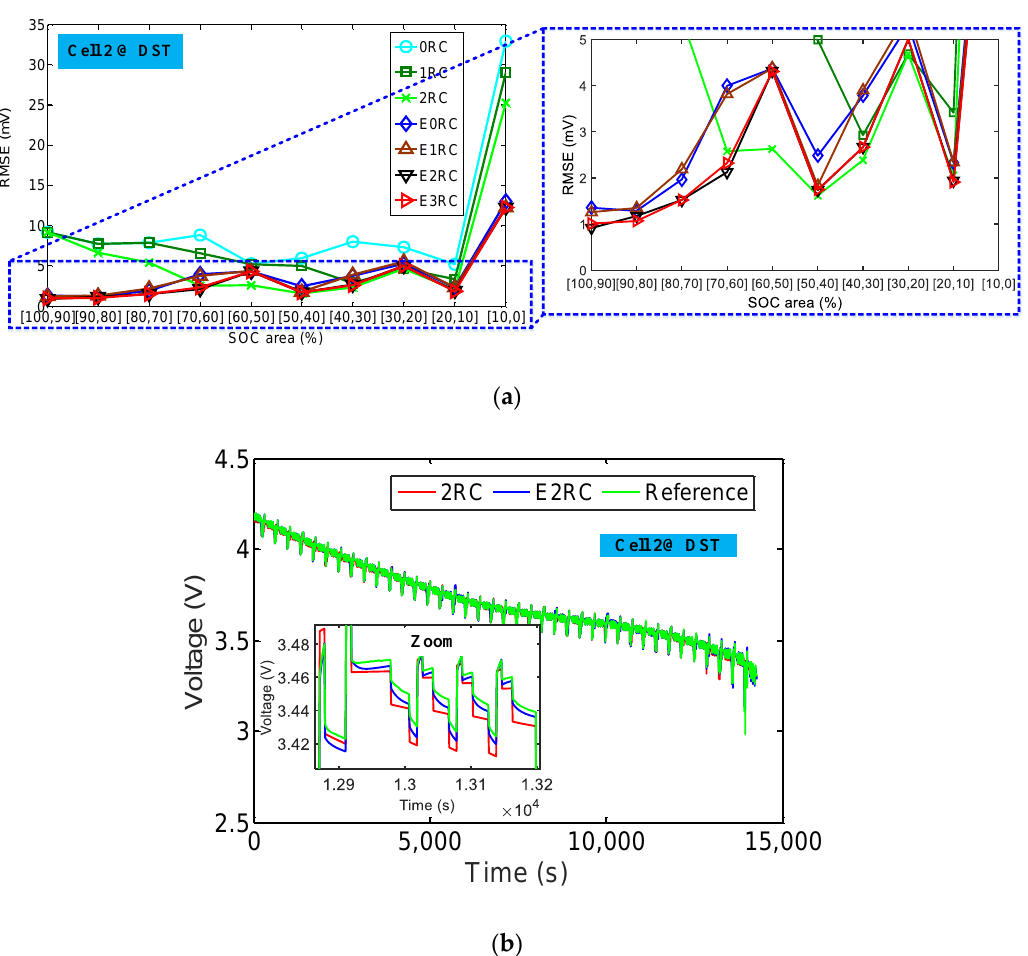
Figure 5. Parameter identification results under dynamic stress test (DST) working condition. ( a ) RMSE comparison; ( b ) Terminal voltage profiles for 2RC and E2RC.